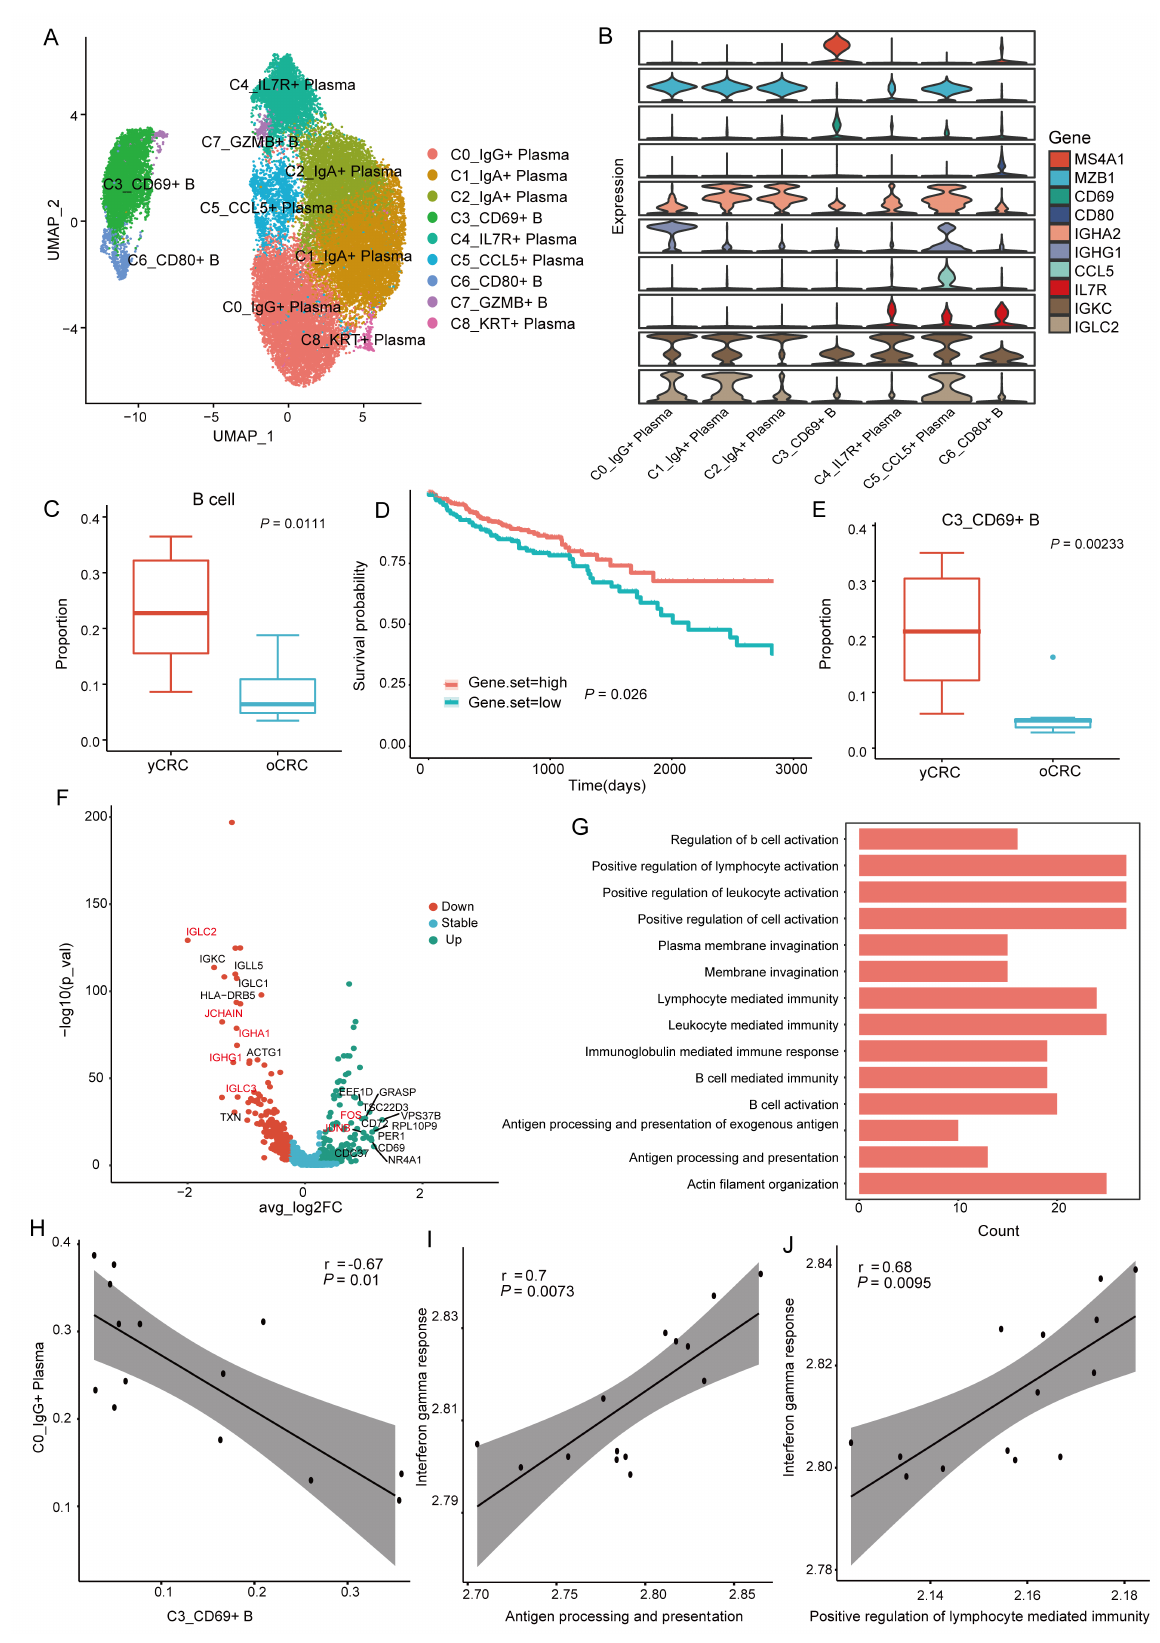
Figure 4. B cells and plasma cells subtypes and their heterogeneity in yCRC and oCRC. ( A ) UMAP plot showing the subtypes of B/plasma cells. ( B ) Violin plots comparing the relative expression of